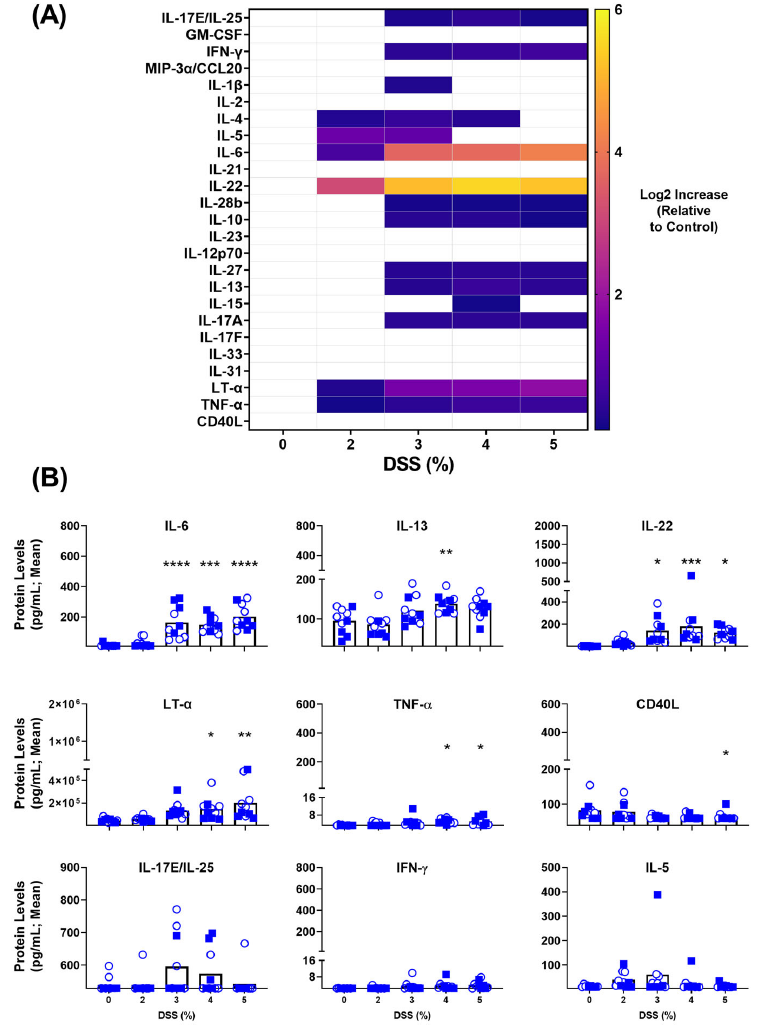
Figure 2. Inflammatory markers dysregulated within acute, DSS-mediated colitis model. C57BL/6 mice (n = 10/group) were exposed to dextran sulphate sodium (DSS) within drinking water (0–5% m / v ) for a period of 7 days. At the end of the study period, serum was collected and used for a multiplexed cytokine/chemokine analysis. Raw concentration values were determined through use of a standard curve using the Milliplex™ Analyst software. These values were normalized to the control animals for a baseline, and the mean Log2 Increase was plotted ( A ). Grouped raw concentration data ( B ) are presented as mean + standard error of mean (SEM). Circles (empty) and squares (filled) represent female and male mice, respectively. Statistical significance of differences are compared relative to the control (0% DSS) group and are shown as *: p < 0.05, **: p < 0.01, ***: p < 0.001 & ****: p < 0.0001 by one ‐ way ANOVA followed by Dunnett’s multiple comparison test. The y ‐ axis is set to start at the LLOQ of the particular cytokine in our assay. To induce experimental colitis, Rag1 ‐ / ‐ and Rag2 ‐ / ‐ mice (n = 5 of each per group) were injected i.p. with either a PBS vehicle solution or 5 × 10 5 proinflammatory naïve T cells isolated from wild ‐ type animals of the same genetic background (C57BL/6). Animals were monitored for clinical signs of disease for a period of 64 days. While the same DAI